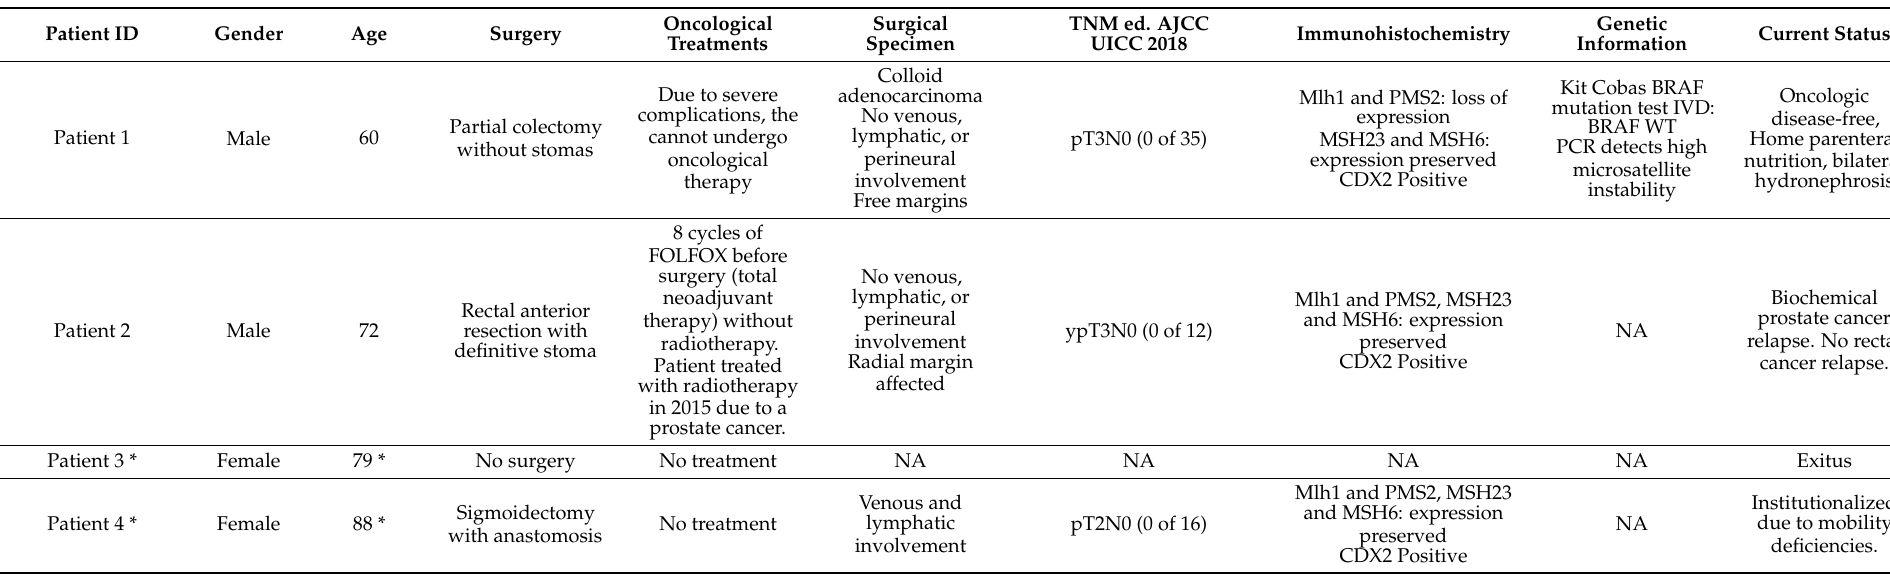
Table 2. Patient clinical